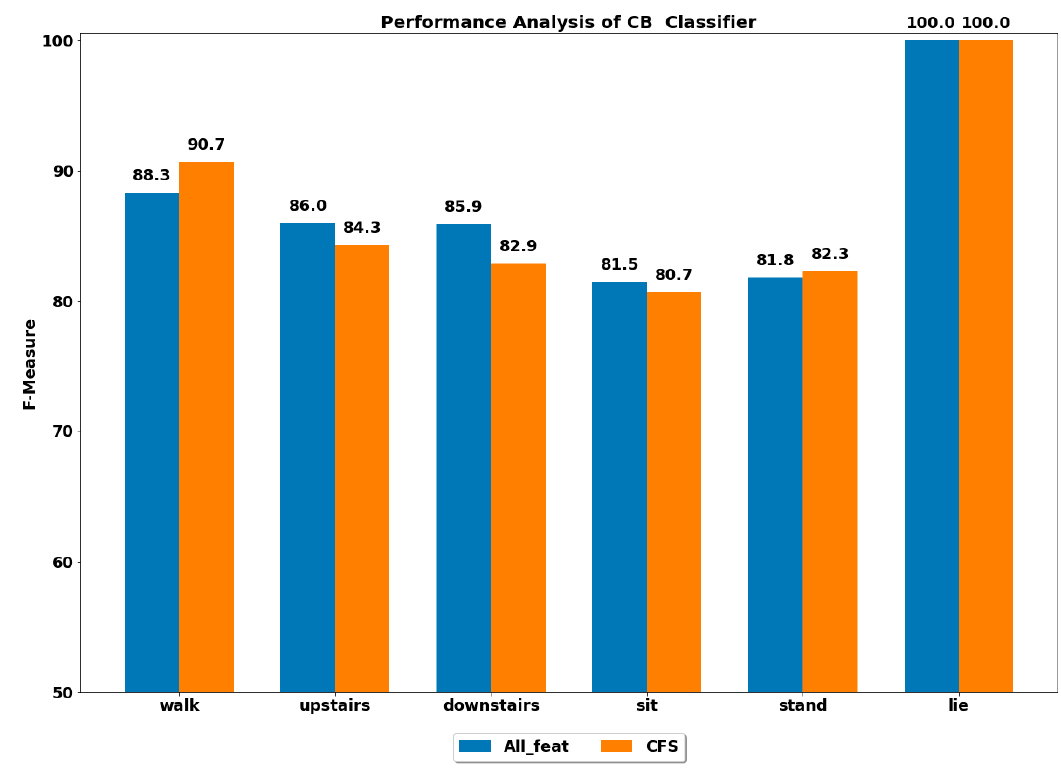
Figure 5. Performance analysis of GB (gradient boosting) classifier with and without feature selection to classify set of ADLs.